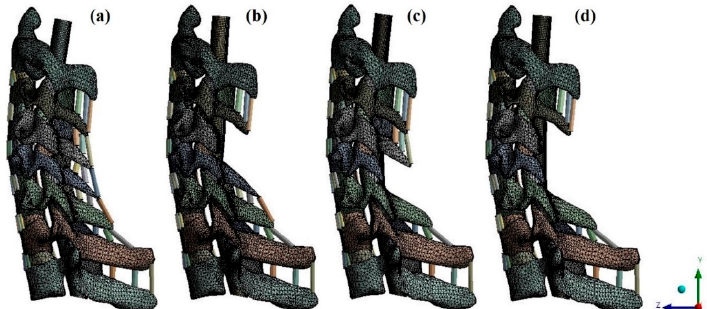
vertebra; and ( c ) type 3 OPLL: connected vertebra.